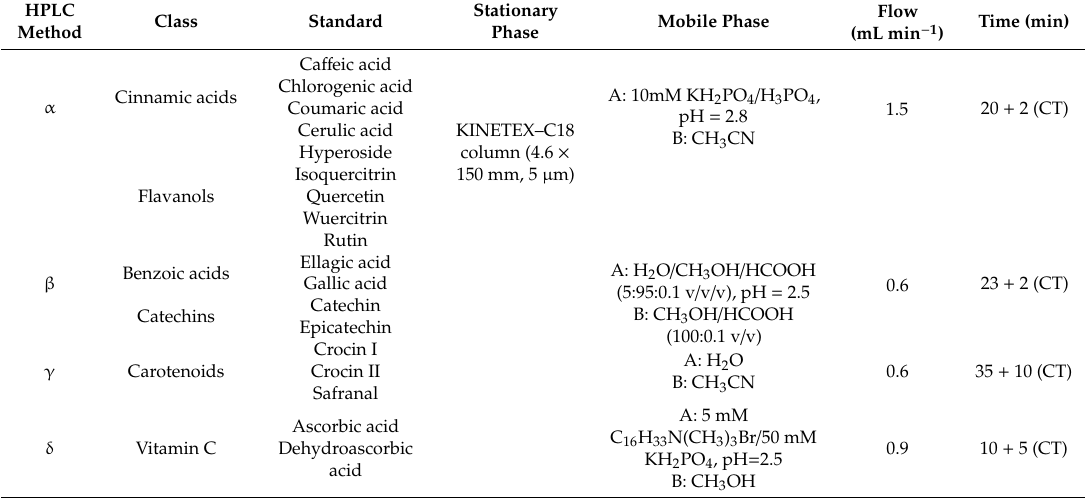
Table 1. Characteristics of the HPLC methods applied to analyse the bioactive compounds present in the studied sa ff ron